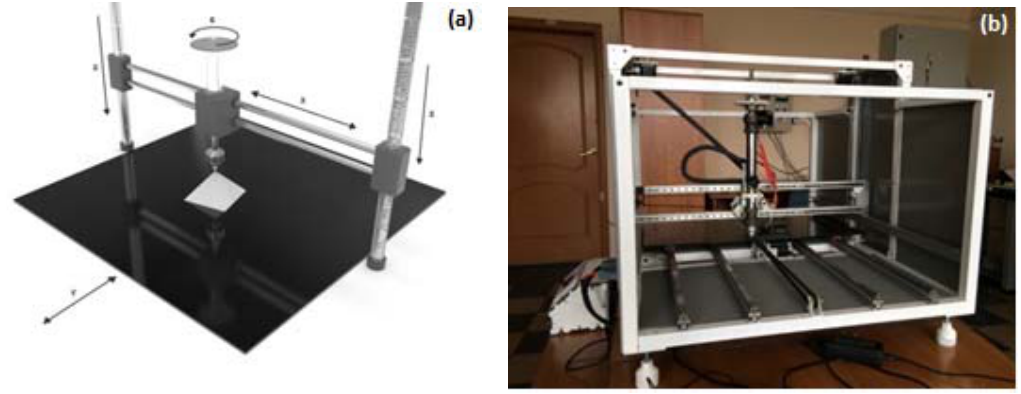
Figure 2. Three ‐ dimensional (3D) printer ( a ) scheme and ( b ) general view. Figure 2. Three-dimensional (3D) printer ( a ) scheme and ( b ) general